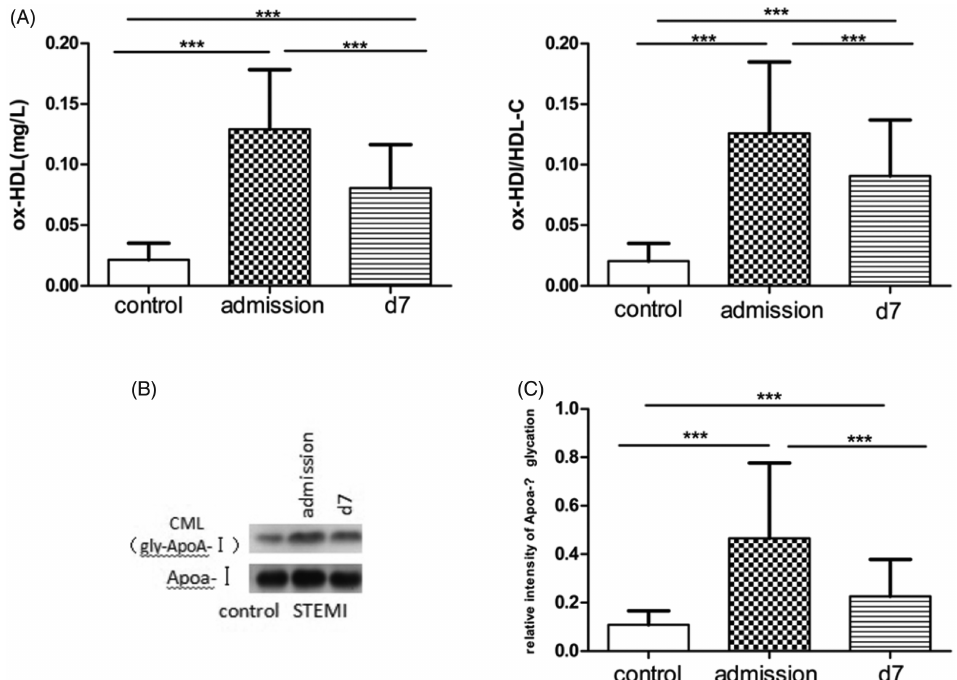
Figure 1. Plasma ox-HDL, ox-HDL/HDL-C, gly-ApoA-I, and relative intensity of ApoA-I glycation in STEMI patients. A: Plasma ox-HDL and ox-HDL/HDL-C were meas- ured in STEMI patients on admission and d7. B: Gly-ApoA-I was determined in STEMI patients on admission and d7 by Western blot. CML: gly-ApoA-I. C: We also calculated relative intensity of ApoA-I glycation. # p > 0.05,